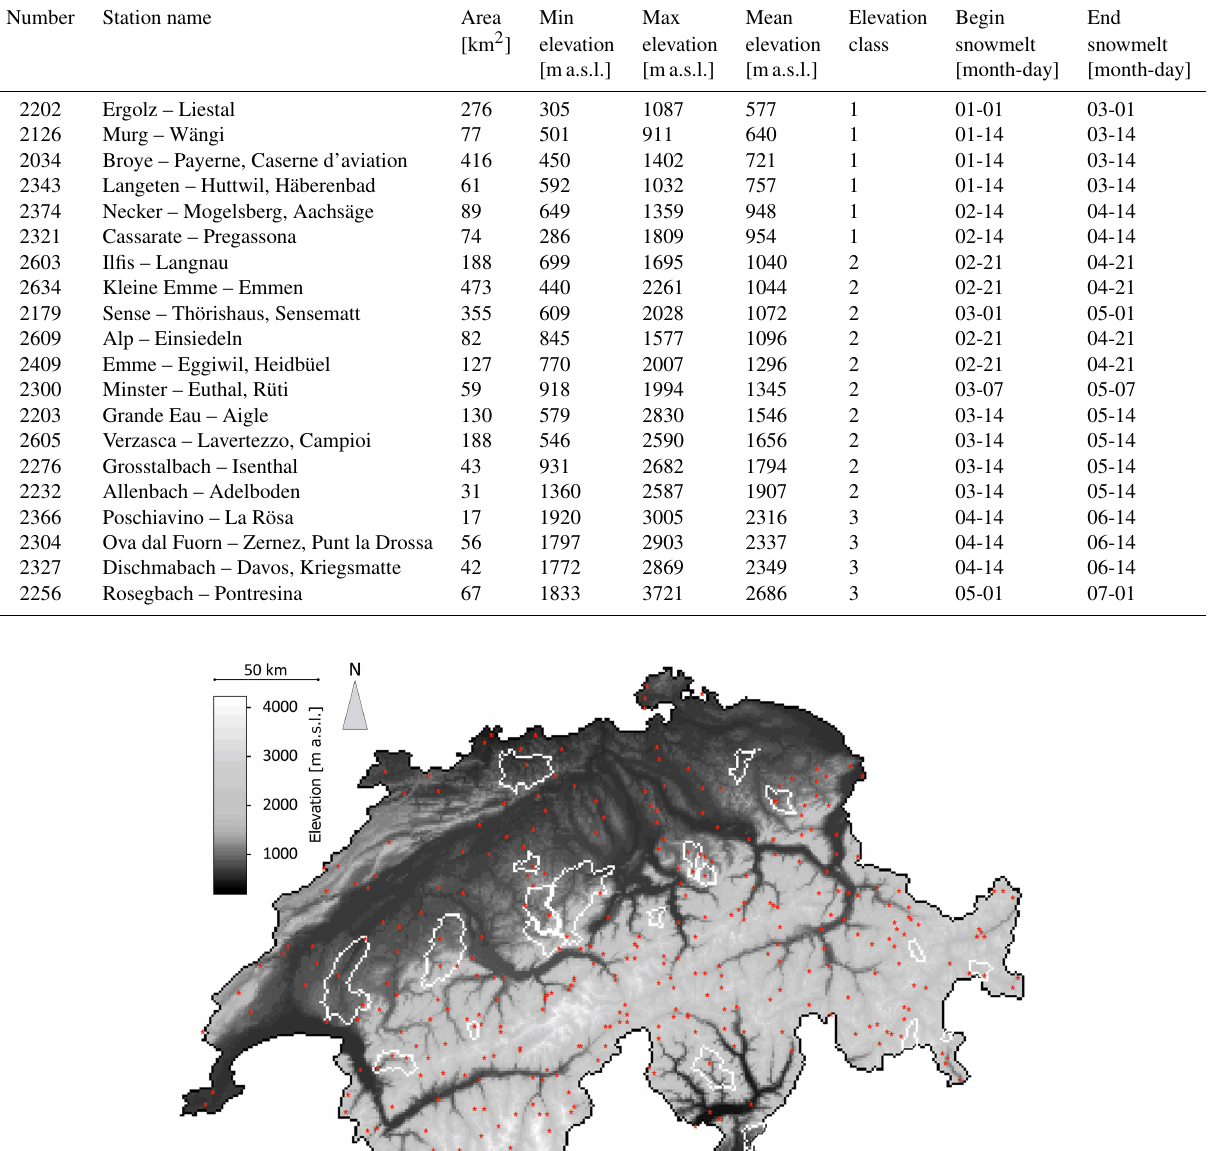
Table 1. Characteristics of 20 Swiss catchments in this study.